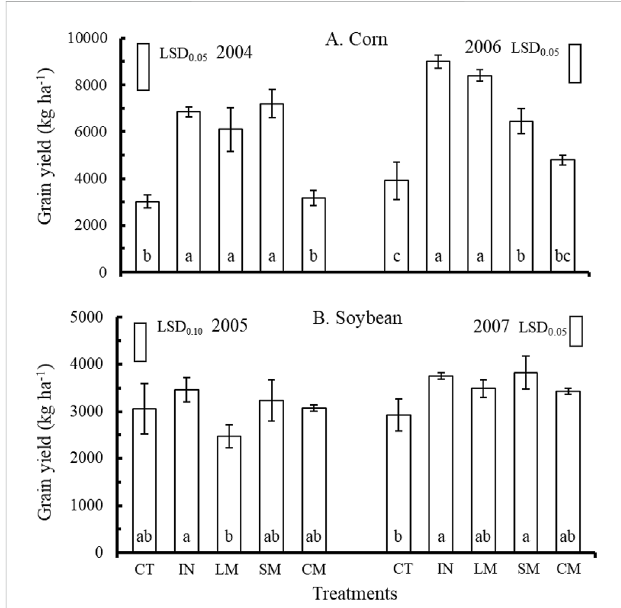
FIGURE 1 Grain yields of corn and soybean in rotation from 2004 to 2007. The abbreviations of CT, IN, LM, SM, and CM referred to the control without fertilization, inorganic fertilizer, liquid swine manure, solid swine manure and composed swine manure, respectively. There was no signi fi cant difference between the bars labeled with the same letter on it within the same year under Fisher ’ s protected LSD test at signi fi cance level of p ≤